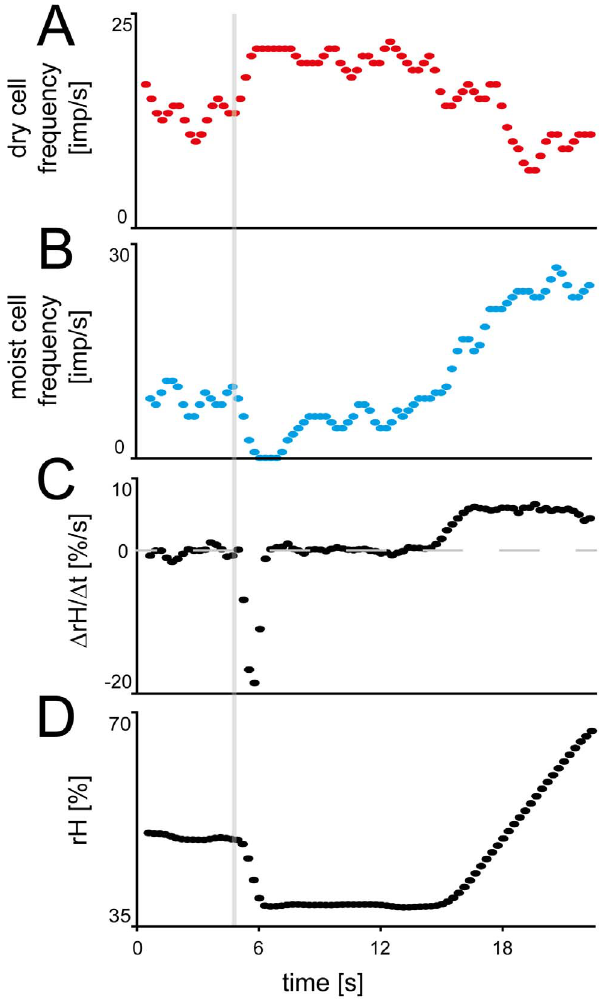
Figure 3. Simultaneously recorded responses of a pair of moist and dry cells from a single sensillum to transient and ramp-like changes in humidity. A and B. Time course of the instantaneous impulse frequency of the moist cell and the dry cell, respectively. Bin width, 1 s. C. Time course of the rate with which the relative humidity changes. D. Time course of the instantaneous relative humidity. rH relative humidity.